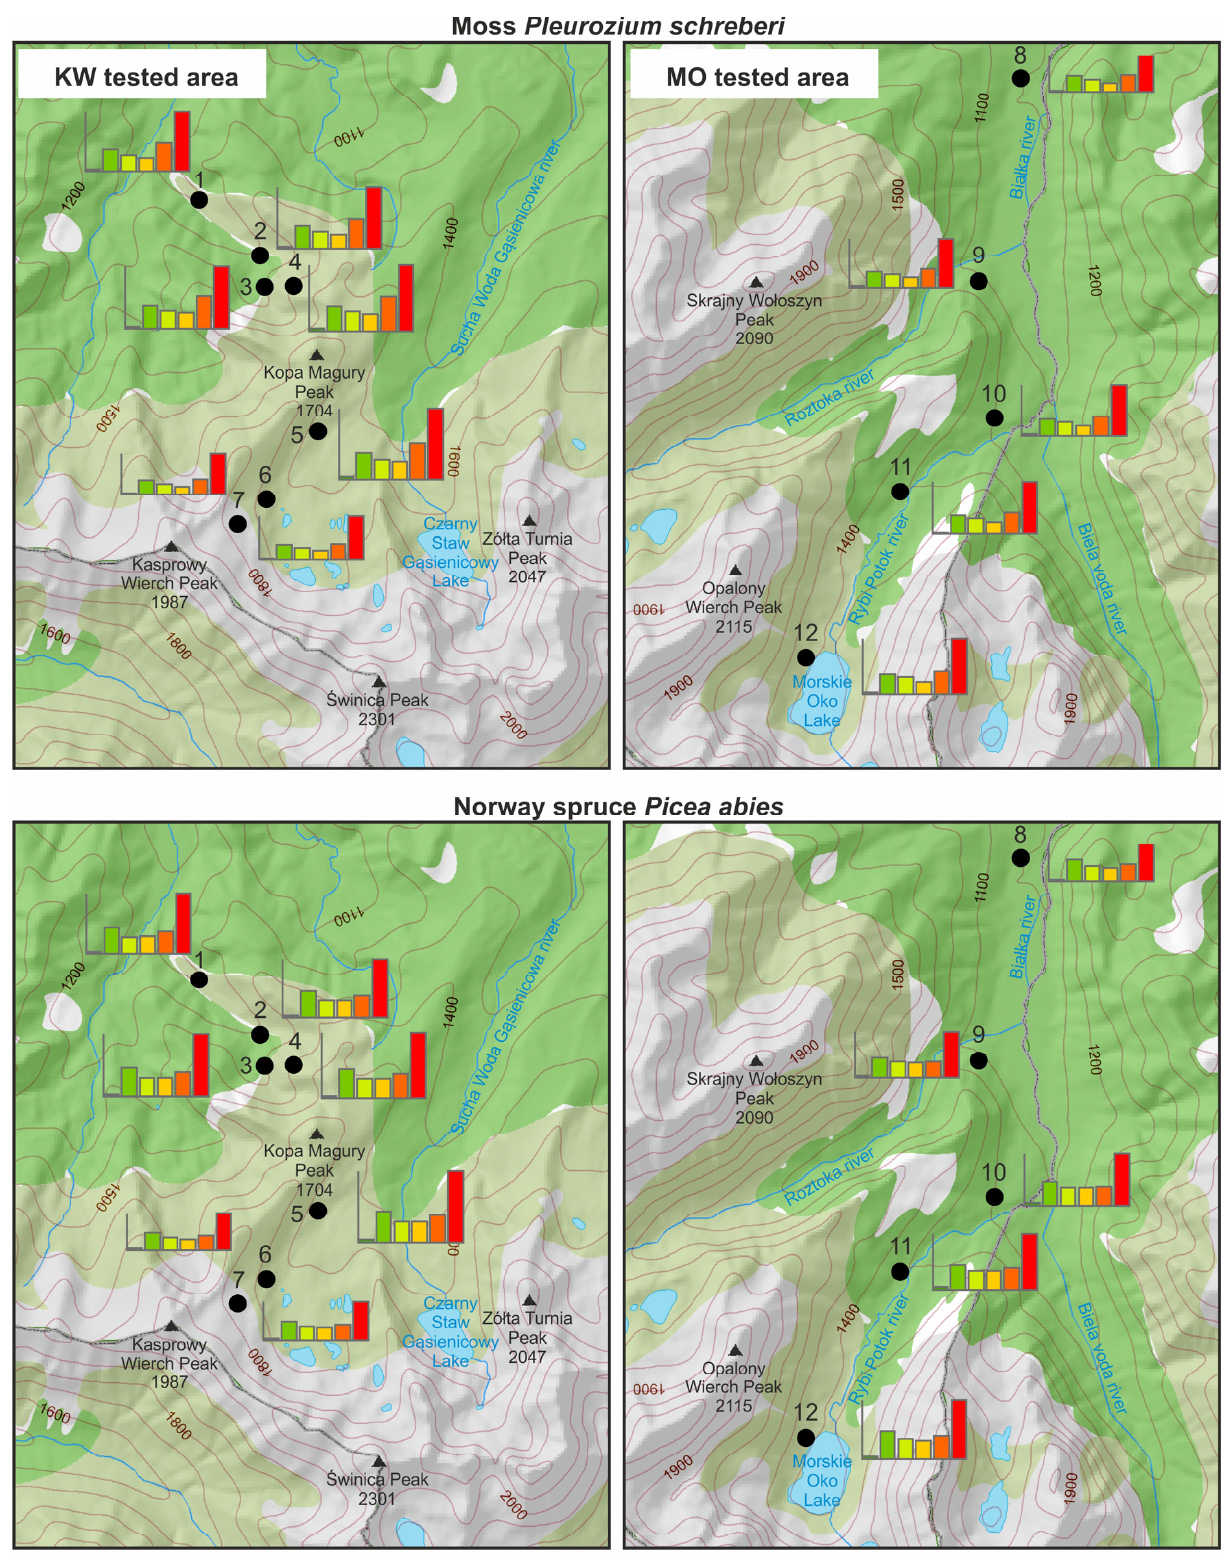
Figure 3. Mean concentrations of heavy metals ( µ g/g d.m.) in the moss species, Pleurozium schreberi , and the Norway spruce, Picea abies , in the Tatra National Park,